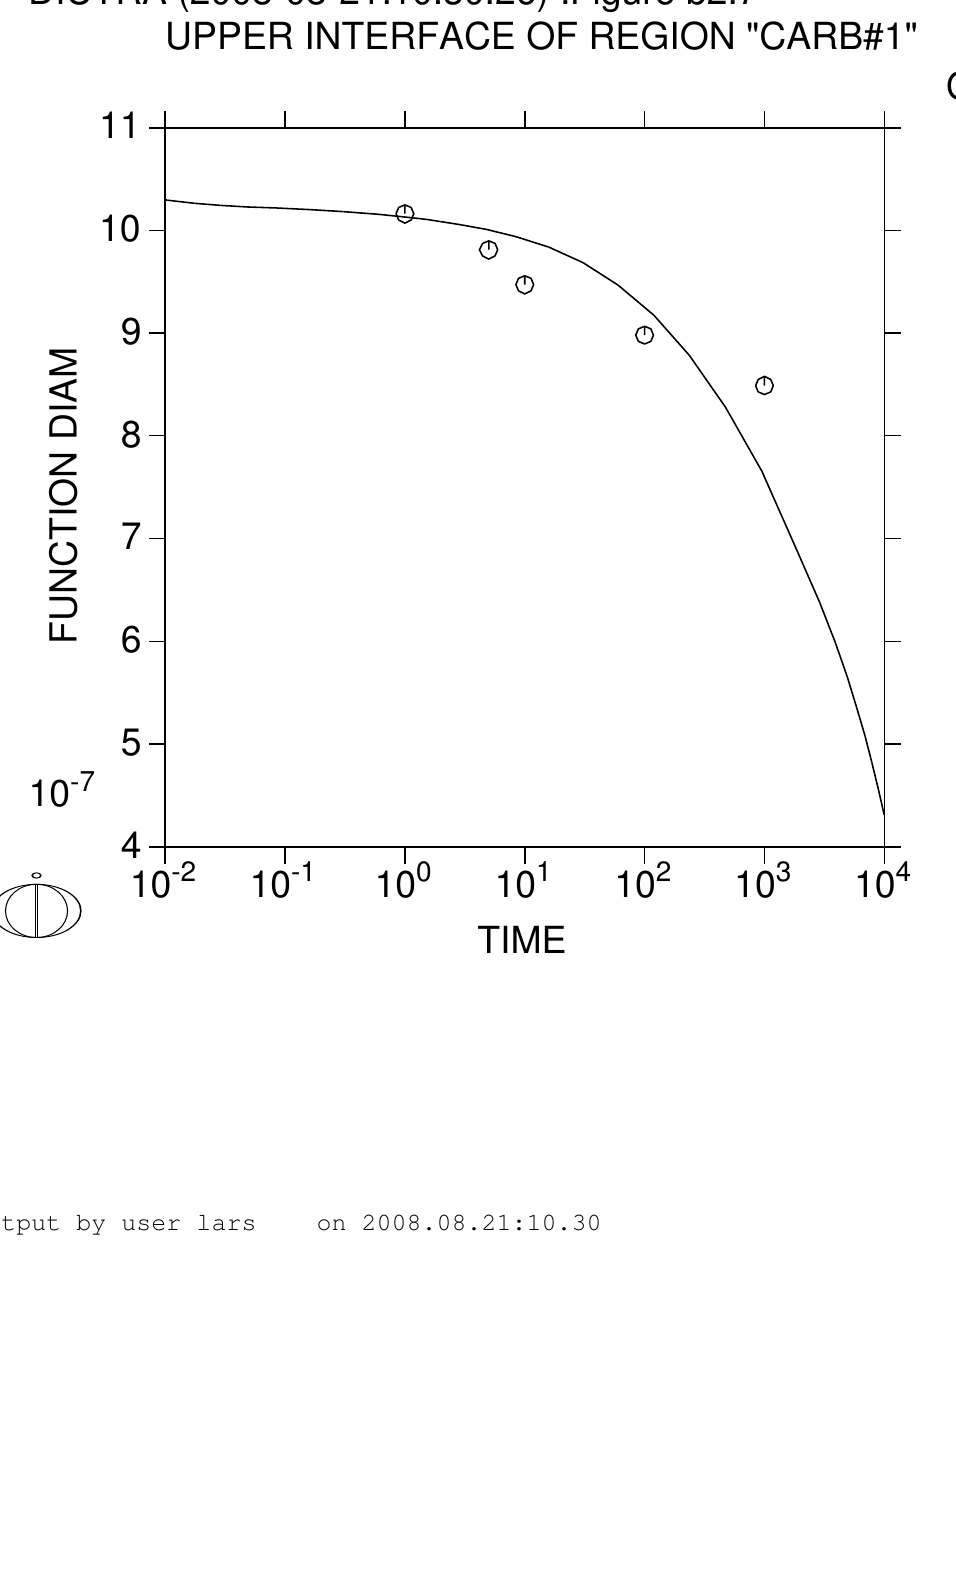
DICTRA (2008-08-21:10.30.26) :Figure b2.7 UPPER INTERFACE OF REGION "CARB#1"